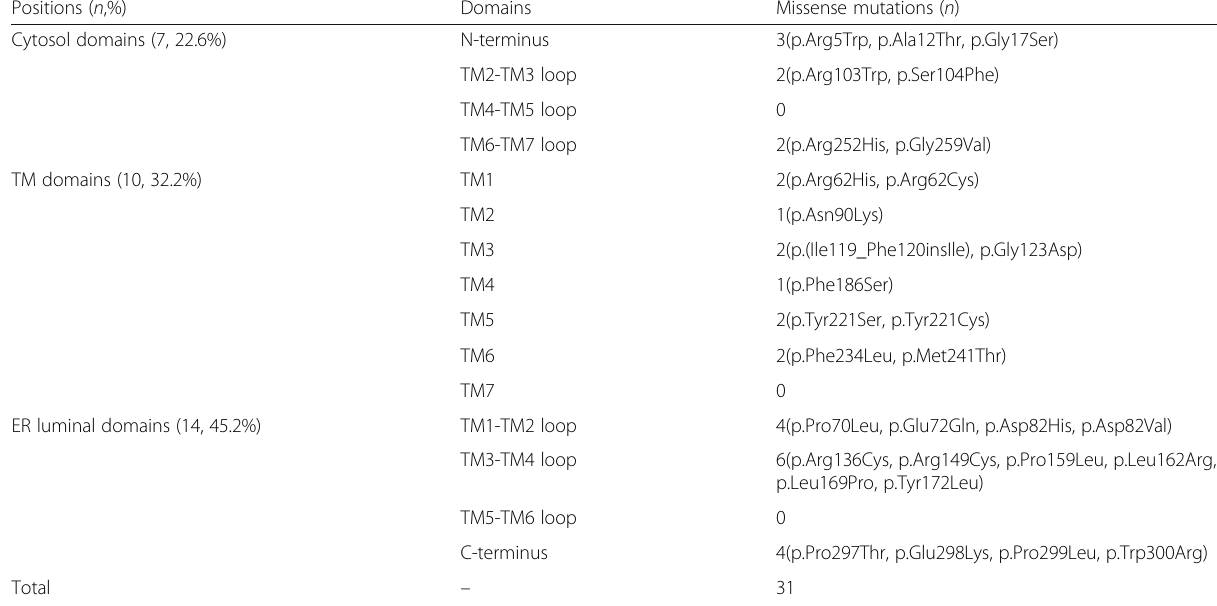
Table 2 Distribution of missense mutations in CLN6 according to the position Positions ( n ,%) Domains Missense mutations ( n ) Cytosol domains (7, 22.6%)